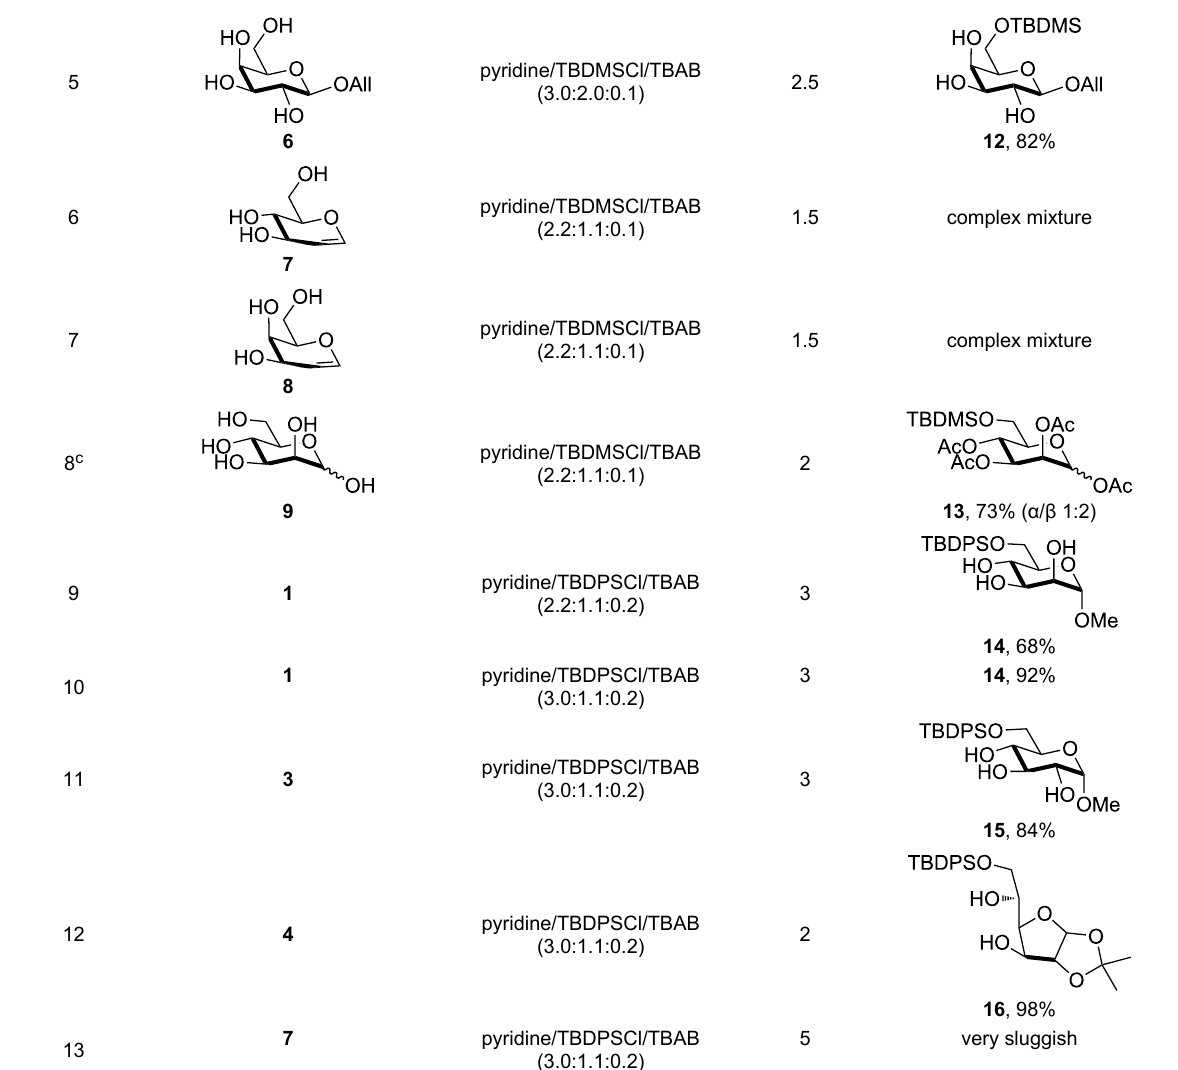
Table 2: Regioselective silylation of saccharide primary alcohols under solvent-free conditions a . (continued)